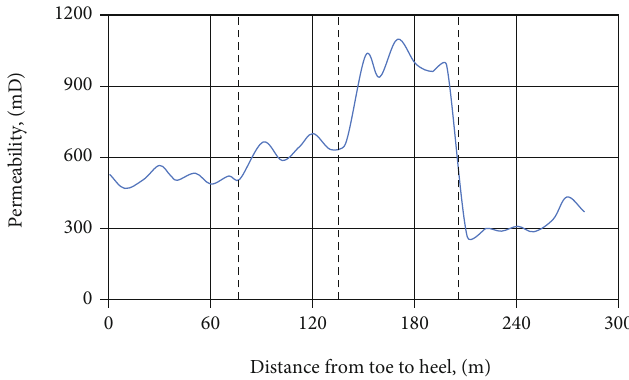
Figure 15: Distribution of permeability along the wellbore divided into 4 sections. Table 4: Parameters of injection valves. Injection